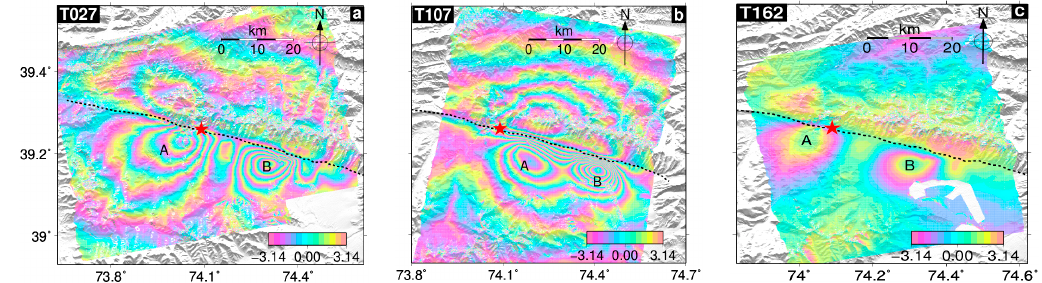
Figure 2. Coseismic interferograms obtained from Interferometric Synthetic Aperture Radar (InSAR) data with coherence above 0.2 are drawn. ( a ) The Sentinel-1A ascending track T027; ( b ) the Sentinel-1B descending track T107; and ( c ) the ALOS-2 ascending track T162. The dashed black line denotes the variable-strike fault surface trace [1] of the 2016 Aketao earthquake. The red star represents the epicenter of this event. The two major deformation areas are labeled by black letters A and B, respectively.